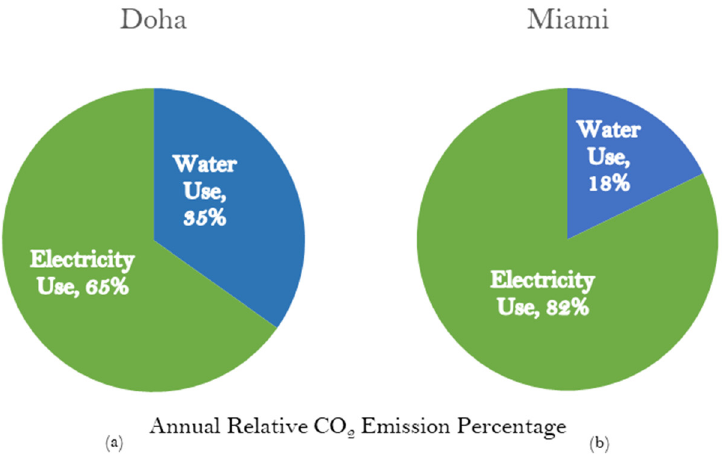
Figure 9. Relative impact assessment of water use in relation to energy use in Doha ( a ) and Miami ( b ).